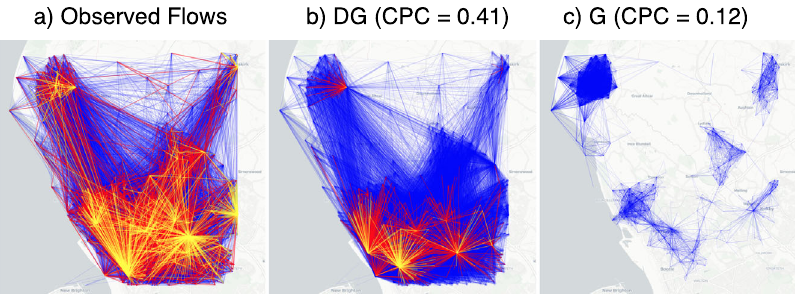
Fig. 2 Real fl ows versus generated fl ows. Visualization of the mobility network describing the observed fl ows ( a ), the fl ows generated by Deep Gravity (DG, panel b ), and those generated by the gravity model (G, panel c ) on a region of interest with 1001 locations (OAs) in the north of Liverpool, England, UK. Colored edges denote observed ( a ) or average fl ows ( b, c ): blue edges indicate fl ows with a number of commuters between 0 and 3, red edges between 3 and 5, and yellow edges above 5 commuters. CPC indicates the Common Part of Commuters. While both DG and G underestimate the fl ows, DG captures the overall structure of the fl ow network more accurately than G.